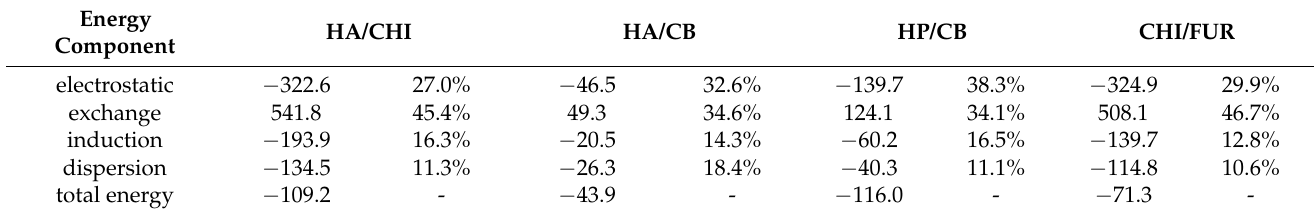
Figure 1. Optimized 3-dimensional structures of polyelectrolyte complexes of HA/CHI, HA/CB, HP/CB, and CHI/FUR with their key hydrogen bond interactions marked in light blue. Table 2. The contributing components to the complexation energy of complexes computed by using the SAPT0/def2TZVP theory level. Values are reported in kcal · mol − 1 and as a percentage of the total SAPT0 energy.